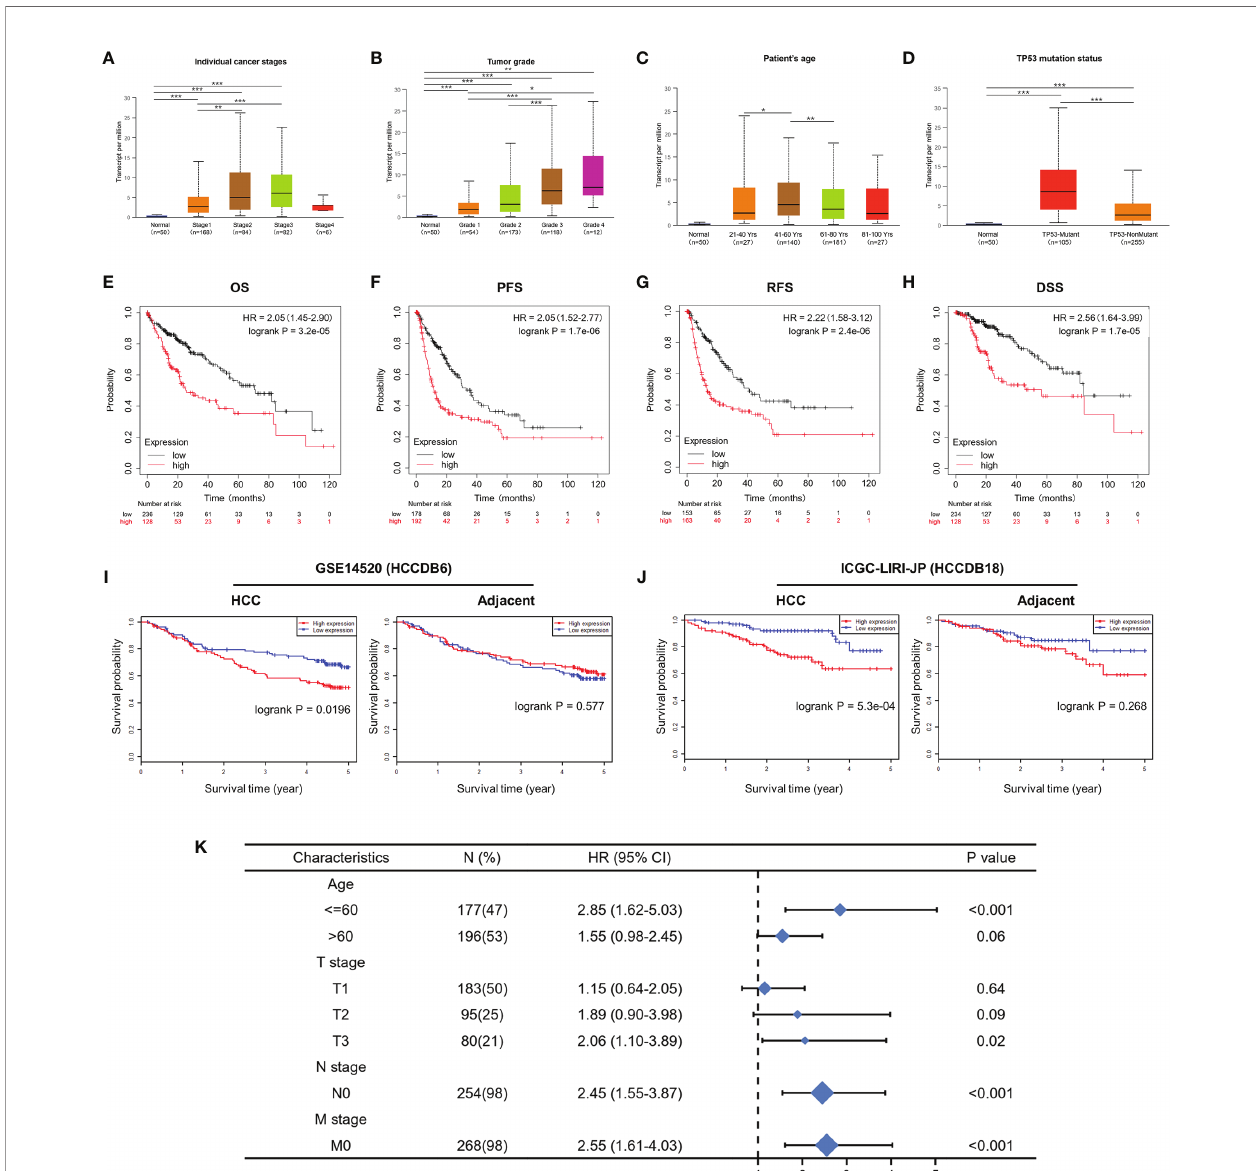
FIGURE 4 | Correlation between CDT1 expression and the clinical parameters of HCC patients and its prognostic signi fi cance. (A – D) Relationship of CDT1 mRNA levels with individual cancer stages, tumor grade, age, and TP53 mutation status of HCC patients. (E – H) Relationship of CDT1 expression with OS, PFS, RFS, and DSS in TCGA database. (I, J) Relationship of CDT1 expression with OS of HCC patients in GEO and ICGC databases. (K) Forest plot showing the impact of CDT1 on OS at different TNM stages and ages. * p < 0.05, ** p < 0.01, *** p <